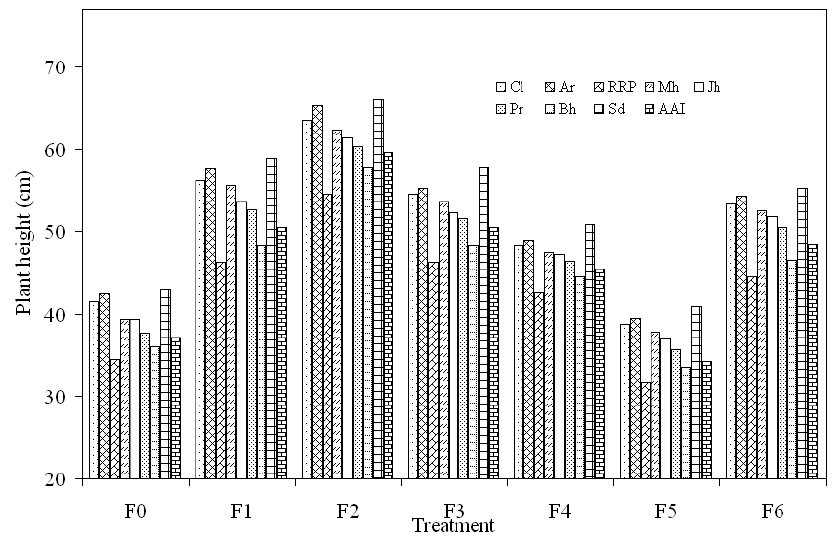
FIGURE 1. Effect of different fertility levels on plant height of wheat plants grown at various sites.